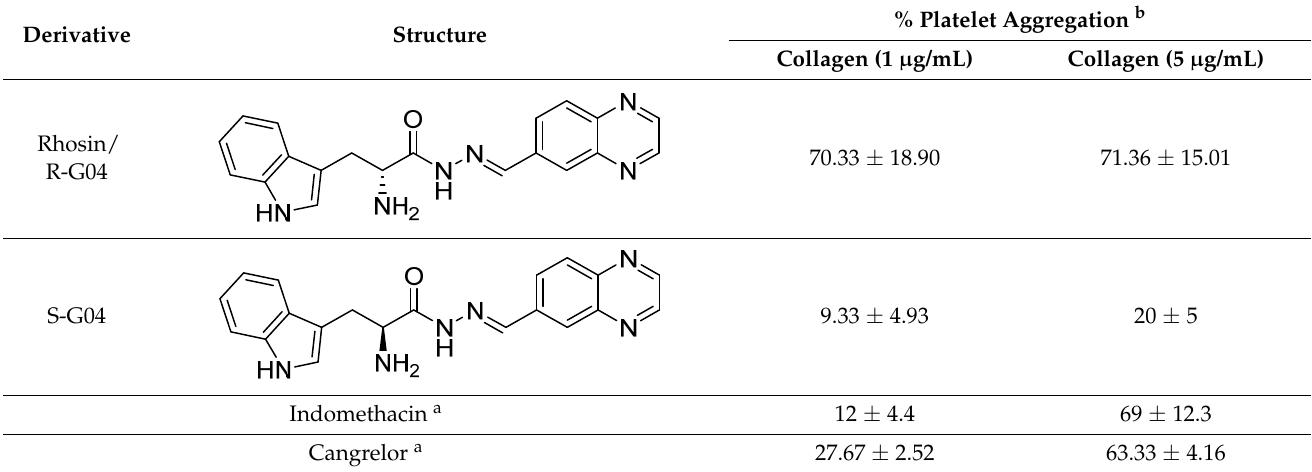
Table 4. Structures of Rhosin/R-G04 and its S-enantiomer, S-G04, and their effects at 20 µM on in vitro collagen-induced platelet aggregation.